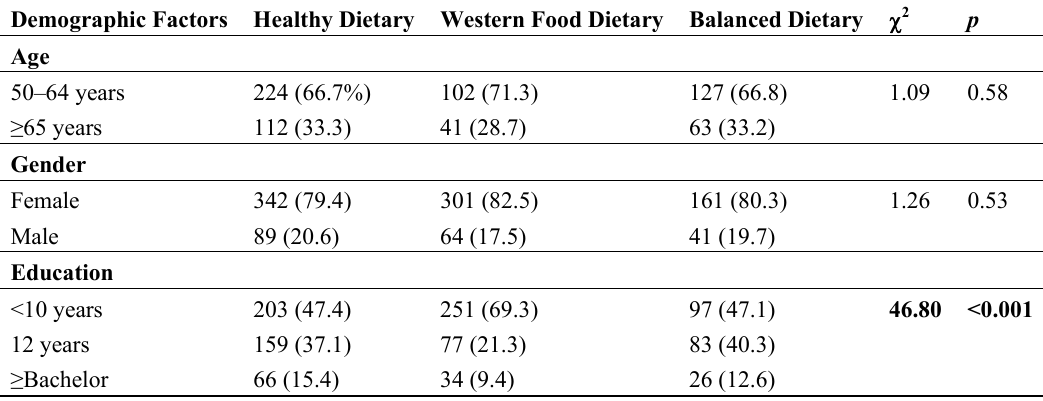
Table 3. Dietary patterns and characteristics of the